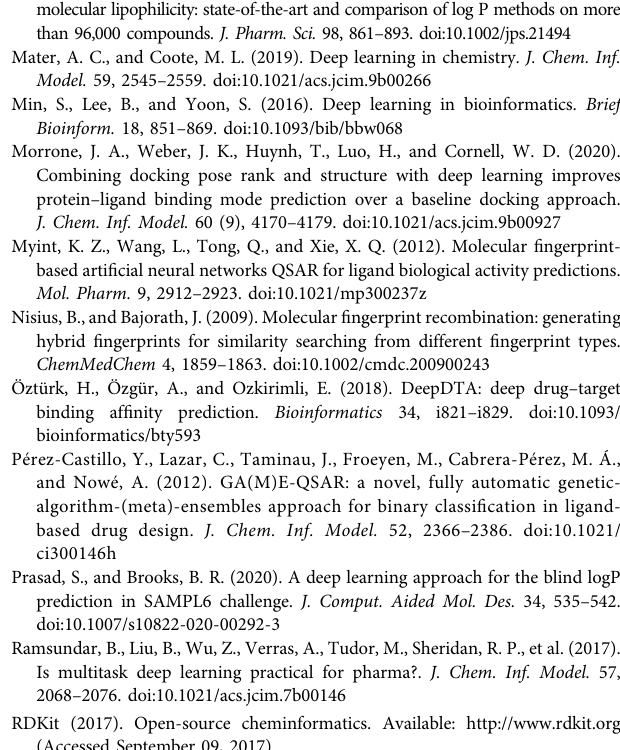
Circular fi ngerprints: fl exible molecular descriptors with applications from physical chemistry to ADME. IDrugs 9, 199 –